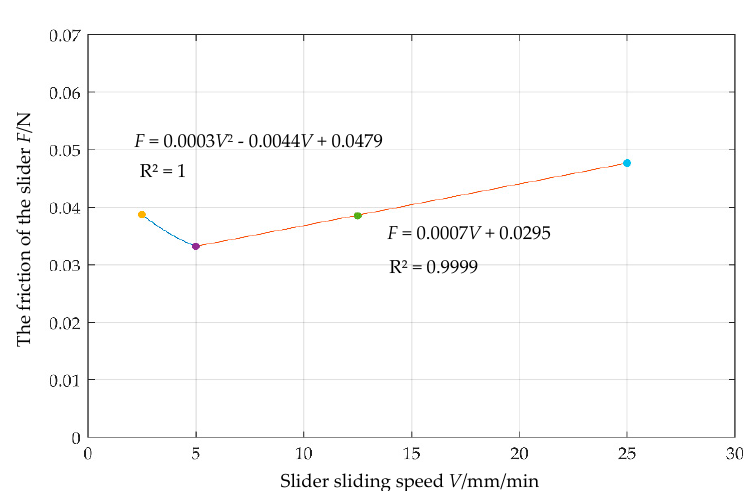
Figure 4. Schematic diagram of the test of sliding friction coefficient.